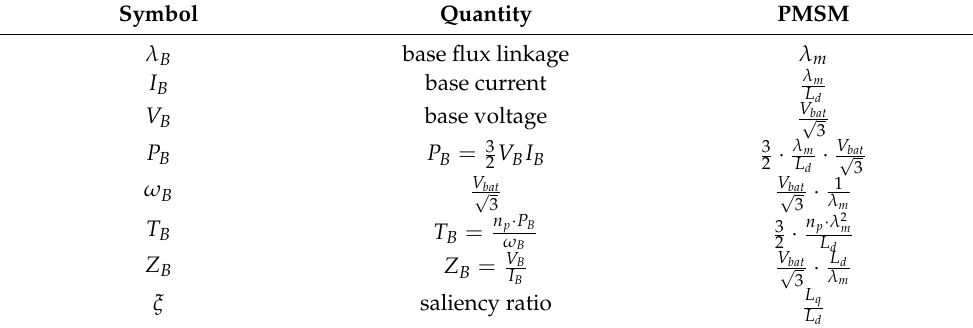
Table 1. Base values of